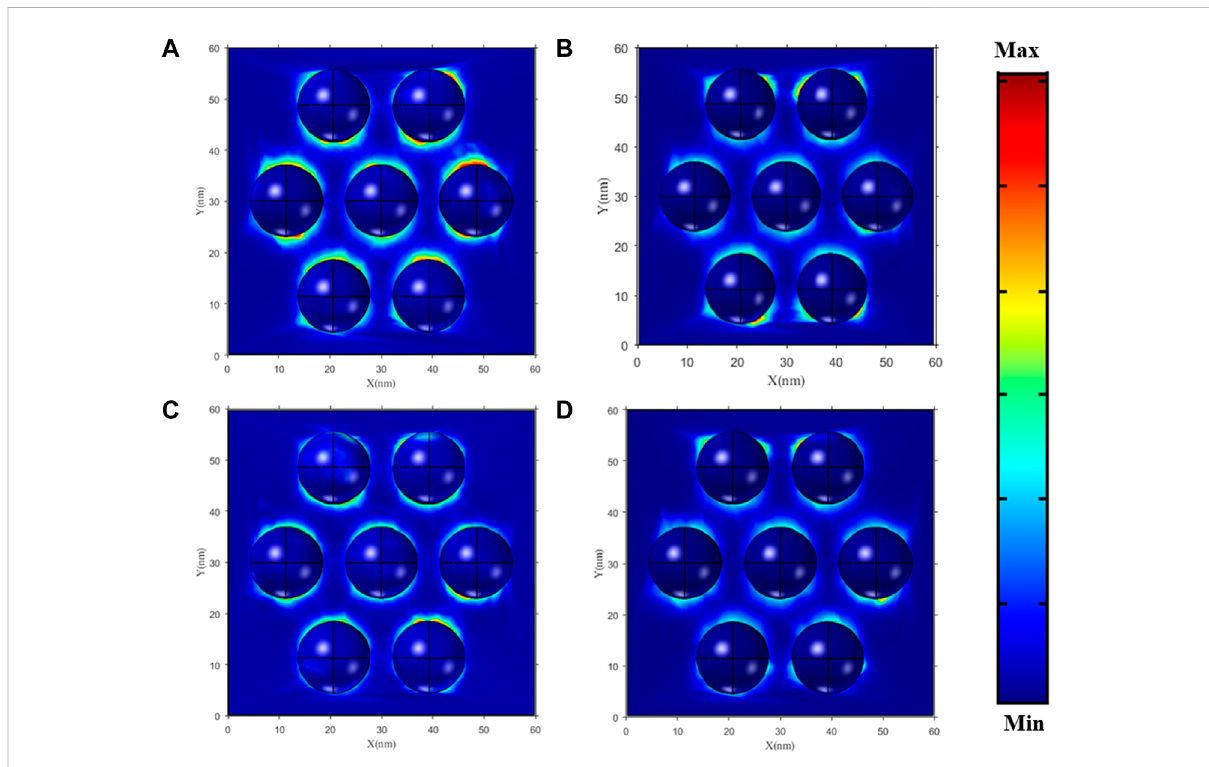
FIGURE 5 The enhancement of the electromagnetic fi eld in GNRs with hydrophobic and hydrophilic substrates with 7-nm gaps (A,C) and (B,D) ,